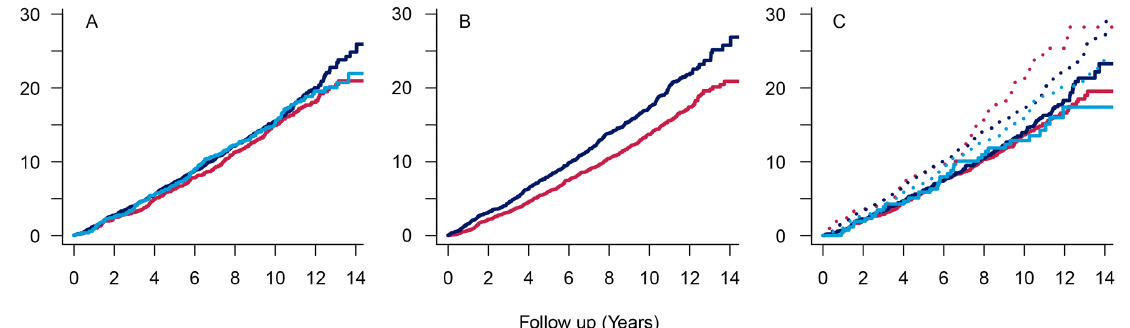
Fig 1. Cumulative incidence of cardiovascular disease as a function of follow-up time according to body mass index categories (A), metabolic syndrome (B) and the joint body mass index and metabolic syndrome phenotypes (C). (A) Red: “ normal weight ” (1,750 individuals), dark blue: “ overweight ” (2,516 individuals), light blue: “ obese ” (1,048 individuals).These incident curves do not differ significantly from each other over the follow-up (log-rank test, P = 0.395). (B) Red: “ without metabolic syndrome ” (3,038 individuals), dark blue: “ with metabolic syndrome ” (2276 individuals).These incident curves differ significantly from each other over the follow-up (log-rank test, P = 0.001). (C) Solid lines indicate individuals without metabolic syndrome and dotted lines individuals with metabolic syndrome. Red: “ normal weight ” (including 1444 without metabolic syndrome and 306 with metabolic syndrome); dark blue: “ overweight ” (including 1334 without metabolic syndrome and 1182 with metabolic syndrome); light blue: “ obese ” (including 260 without metabolic syndrome and 788 with metabolic syndrome). These incident curves differ significantly from each other over the follow-up (log-rank test, P =